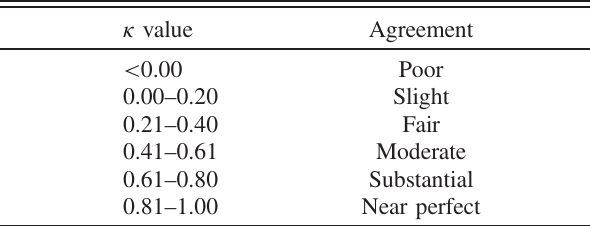
TABLE I. Interrater agreement rubric from